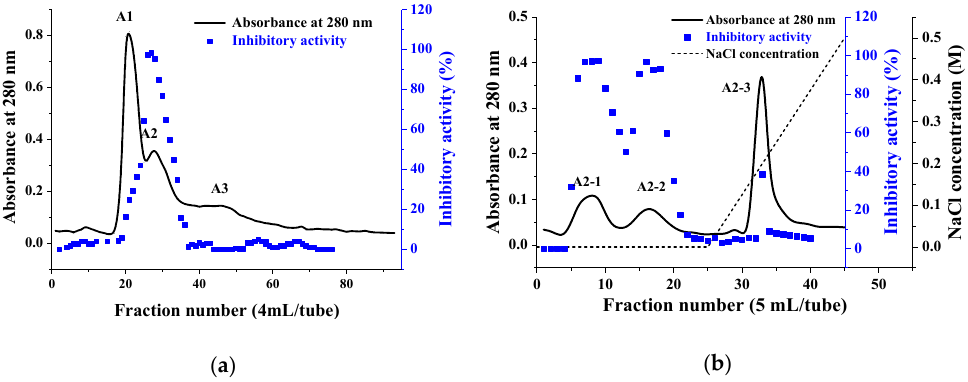
Figure 1. Purification of trypsin inhibitor (PHTI) from the roots of P. heterophylla . ( a ) Gel filtration chromatography on a Sephadex G50 column. ( b ) Ion exchange chromatography on a DEAE-650M column.